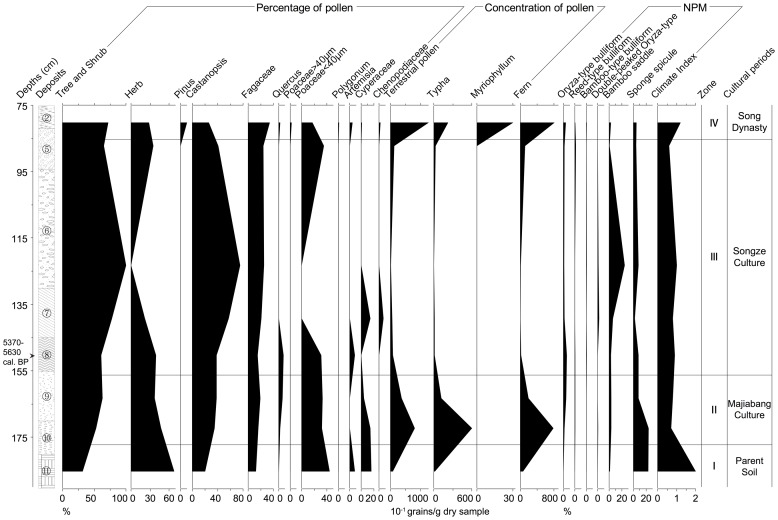
Integrated paleoecological data of P01 from the Jiangli site.